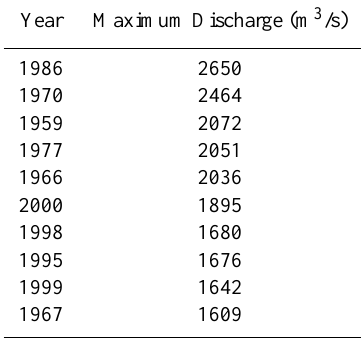
Table 2. Ten highest discharges in